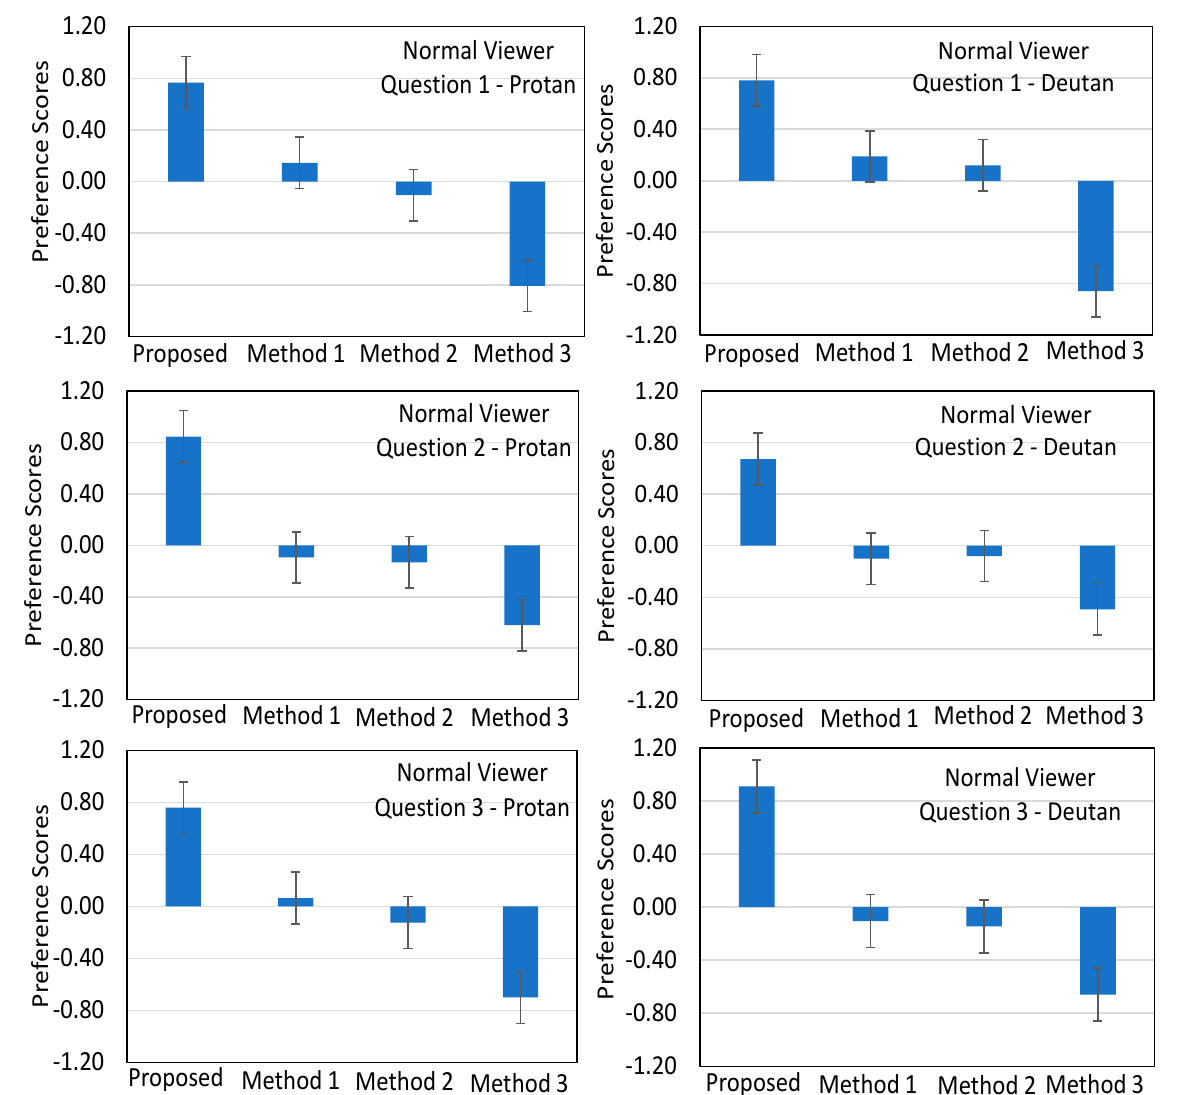
Figure 11. Average preference scores (blue column bars) and the corresponding 95% confidence intervals (error bars) of the pairwise comparisons for the participants belonging to Group 1: ( left column ) reports the results for experiment 1 (recolored paintings for protanopia) for the three questions, and ( right column ) reports the results for the experiment 2 (recolored paintings for deuteranopia) for the three questions.